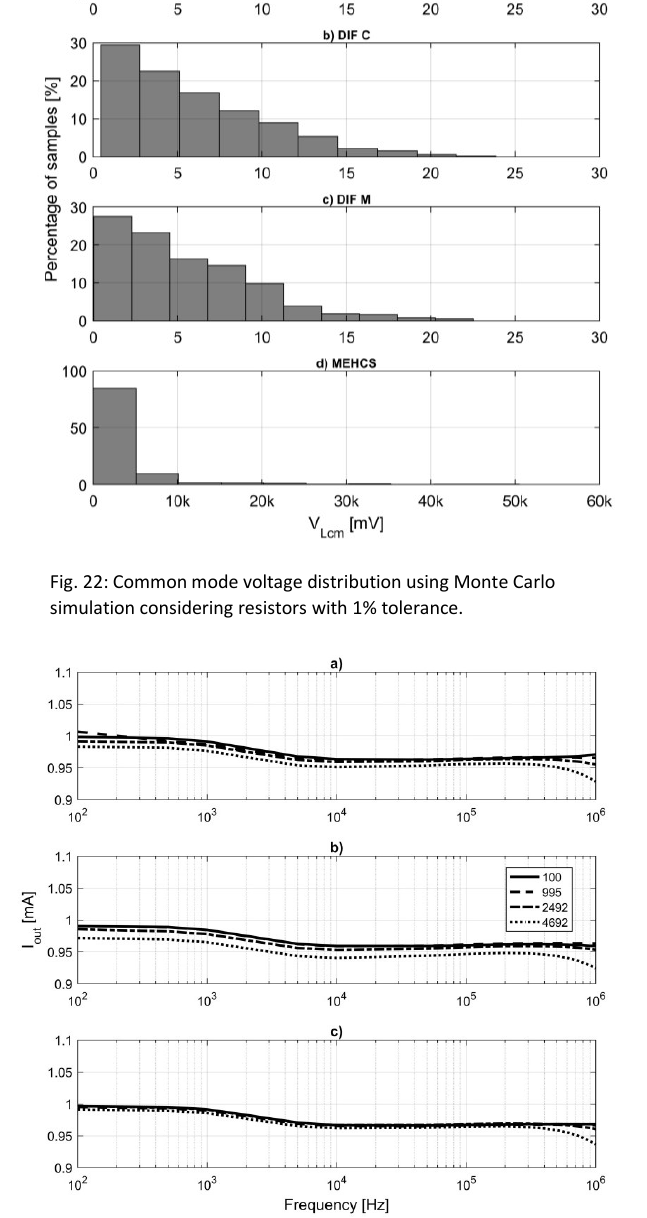
Fig.23: Measured output current for different loads (100, 995, 2492 and 4692 Ω). a) QUAD b) DIF_C c) DIF_M.